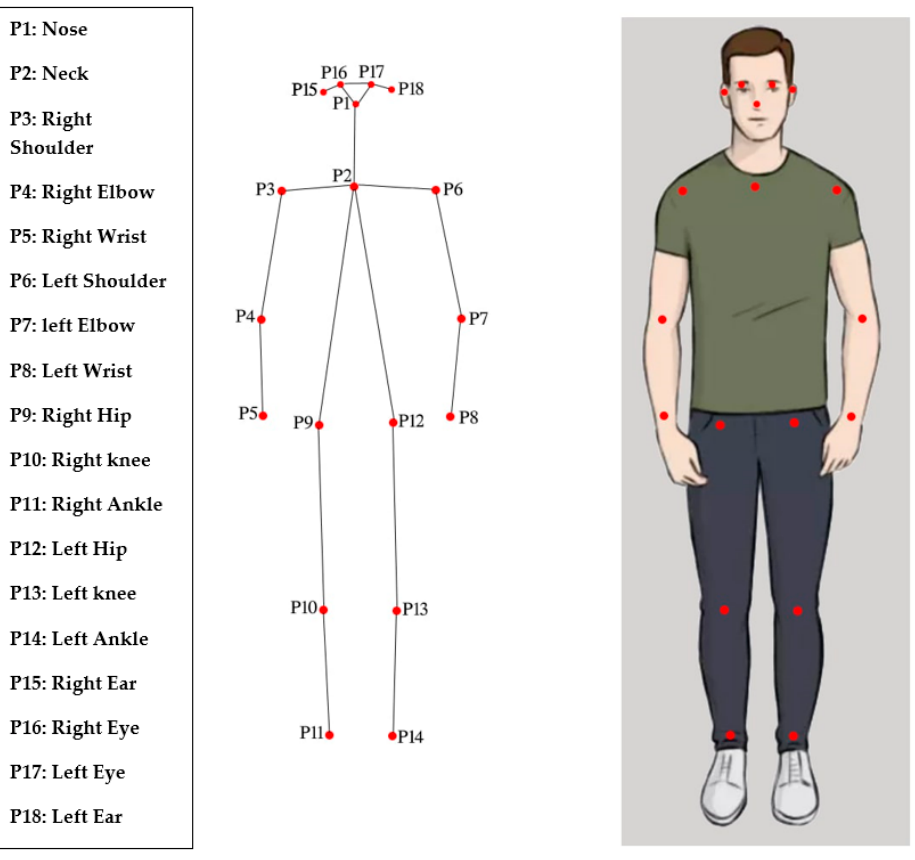
Figure 4. Key points of human Figure 4 . Key points of human bones.